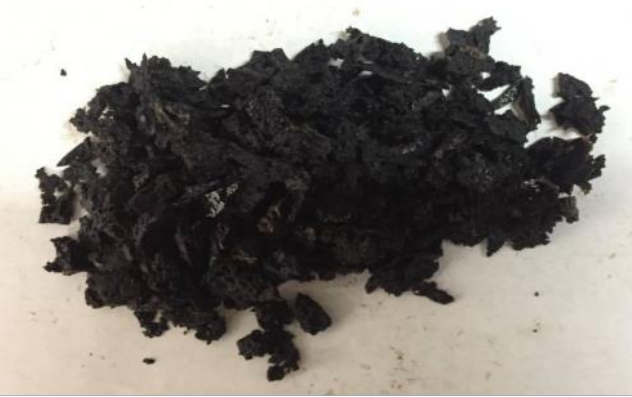
Figure 2. GQDs/SBS composite modifier.